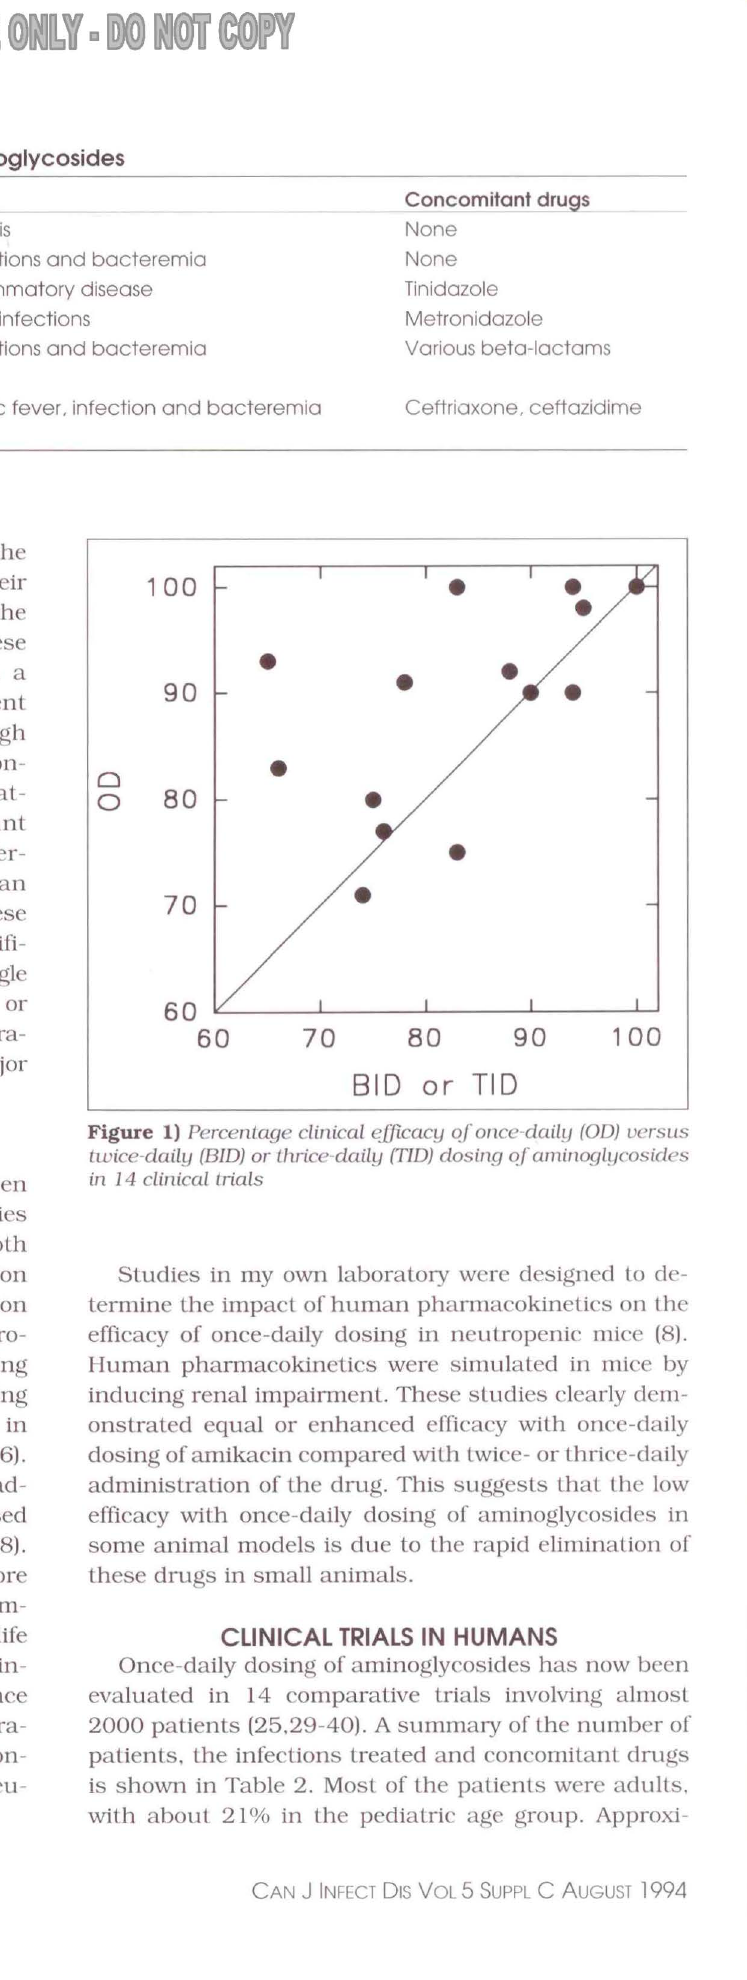
Comparative studies with once-daily dosing of aminoglycosides